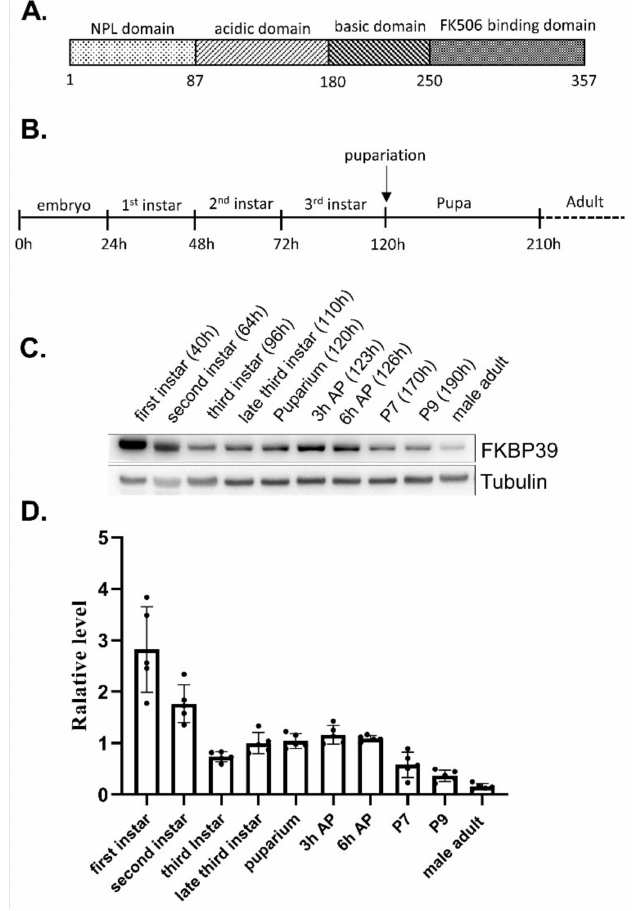
Figure 1. FKBP39 expression during Drosophila development. ( A ) The schematic representa- tion of the putative functional regions of FKBP39. ( B ) The scheme of the fly development stages. ( C ) Western blot analysis of the FKBP39 protein at different development stages. AP, after puparium; P, pupal stage. The pupal stages are according to stages of metamorphosis in Drosophila [22]. The time points of the sample collection are shown. α -Tubulin was used as a loading control for the Western blot. ( D ) Quantification of FKBP39 levels relative to α -Tubulin. Error bars represent the S.D. of five independent